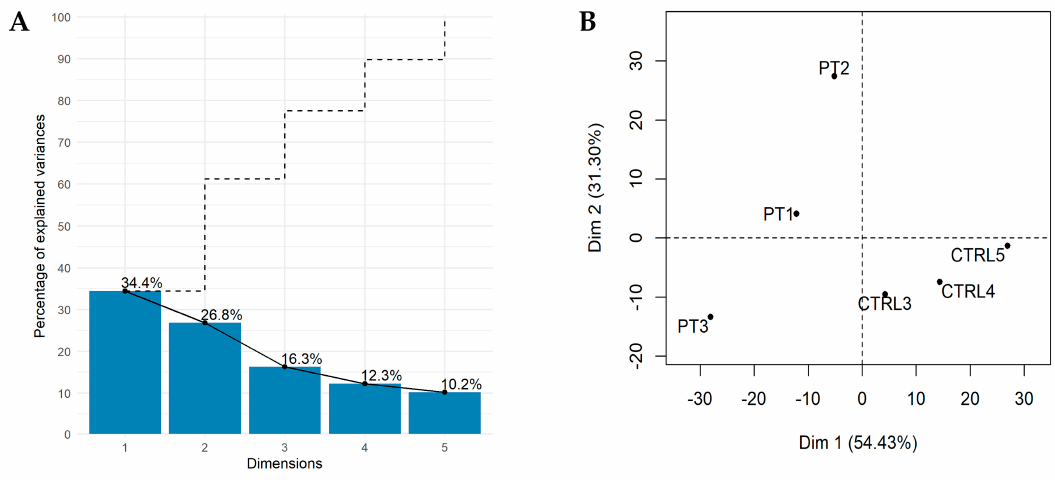
Figure 2. PCA–based feature extraction analysis. In Scree diagram plot ( A ) the proportion of variance and cumulative variance of principal components are shown. Each bar represents an eigenvector (principal component); the numbers above each bar represents the eigenvalue (variance explained) of each eigenvector. The dashed line represents the cumulative explained variance. In ( B ) samples are plotted by using the first two principal components (PC1 and PC2). In the brackets, the variance explained by each principal component.